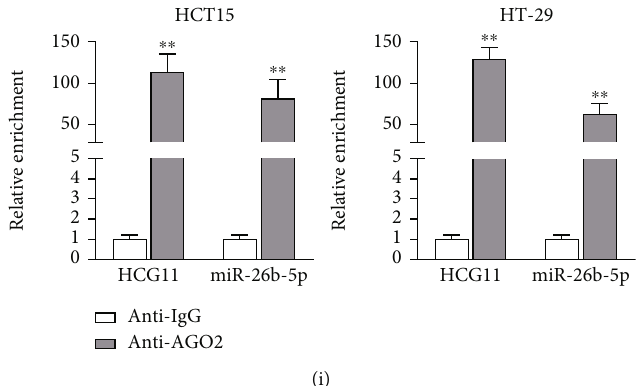
Figure 2: HCG11 sequesters miR-26b-5p in CRC cells. (a, b) Subcellular fractionation and FISH assays were carried out to examine the cellular distribution of HCG11. (c) Putative miRNAs could bind with HCG11 which were predicted based on ENCORI. (d) RNA pull- down assay was conducted to con fi rm the interplay between HCG11 and miRNAs. (e) miR-26b-5p expression in di ff erent cell lines was tested via qRT-PCR. (f) The binding sites of HCG11 and miR-26b-5p obtained from ENCORI were presented. (g) The overexpression e ffi ciency of miR-26b-5p mimics was detected by qRT-PCR. (h) Luciferase reporter assay tested the interplay between HCG11 and miR- 26b-5p. (i) RIP assay tested enrichment of HCG11 or miR-26b-5p in anti-AGO2 or anti-IgG complexes. ∗ p < 0 : 05 and ∗∗ p < 0 : 01